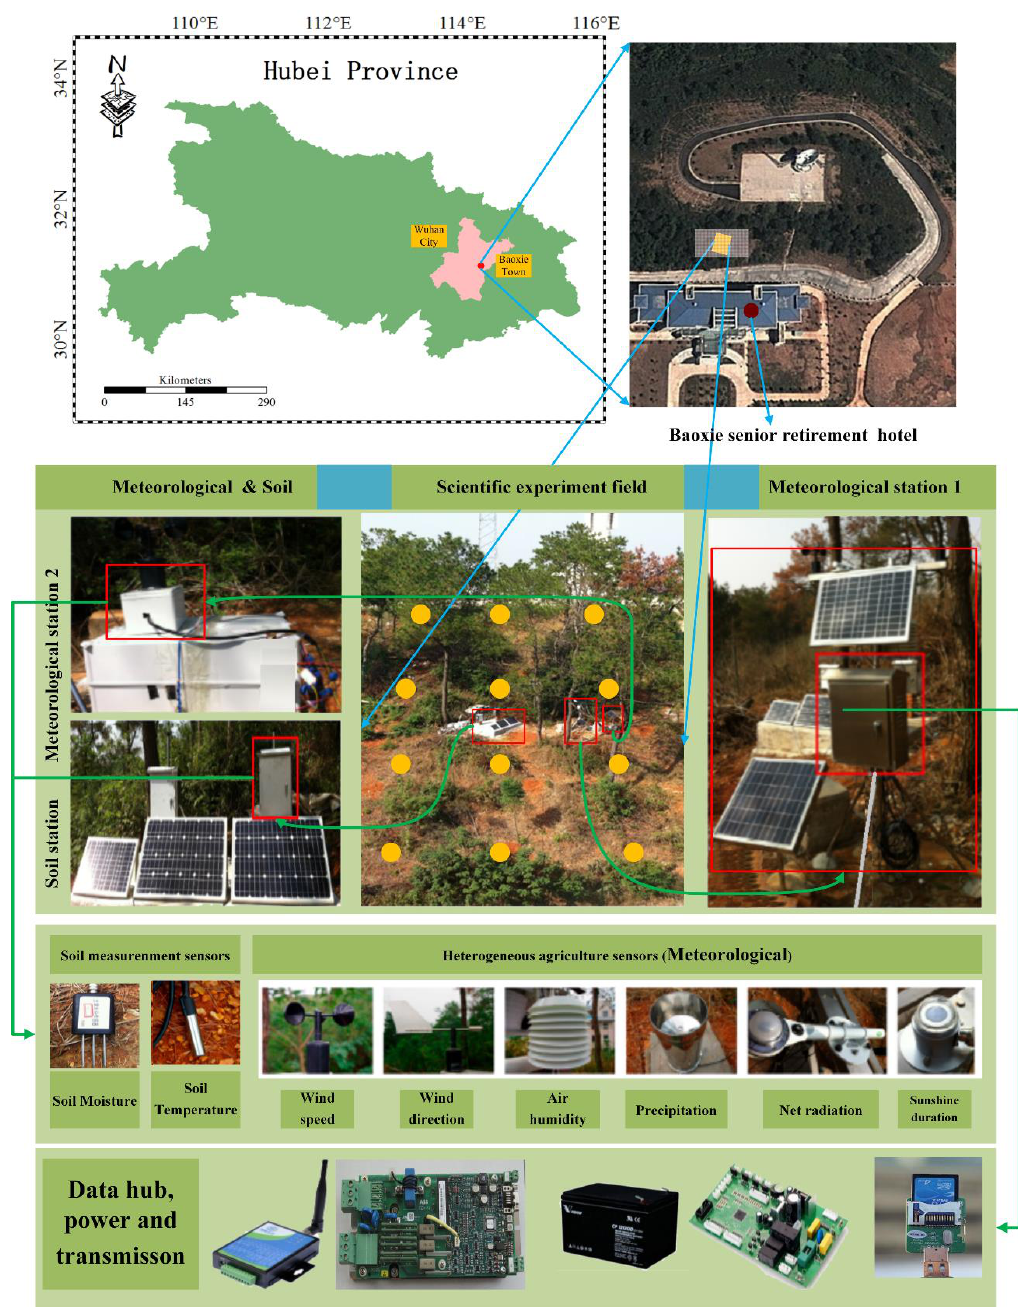
Figure 7. Experimental site and the entire monitoring system of deployed sensors.